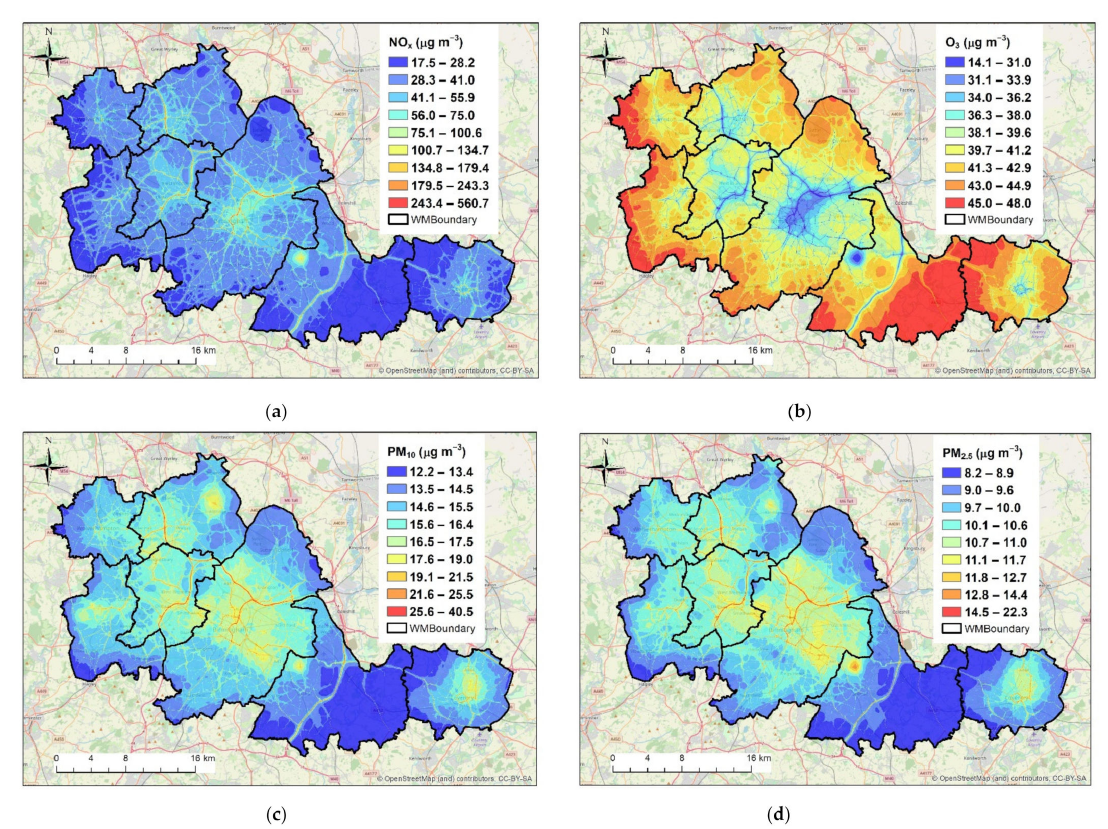
Figure A1. Annual air quality maps for ( a ) NO x (in µ g m − 3 ), ( b ) O 3 (in µ g m − 3 ), ( c ) PM 10 (in µ g m − 3 ) and ( d ) PM 2.5 (in µ g m − 3 ) at 10 m × 10 m